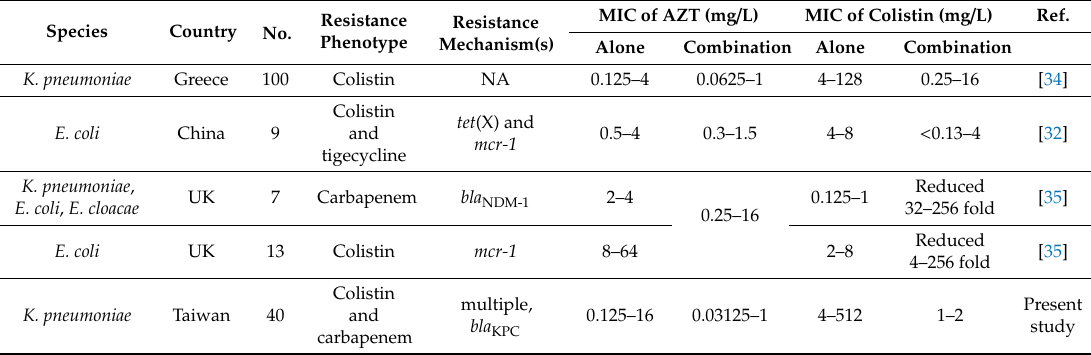
Table 6. Combination therapy against Enterobacteriaceae in di ff erent